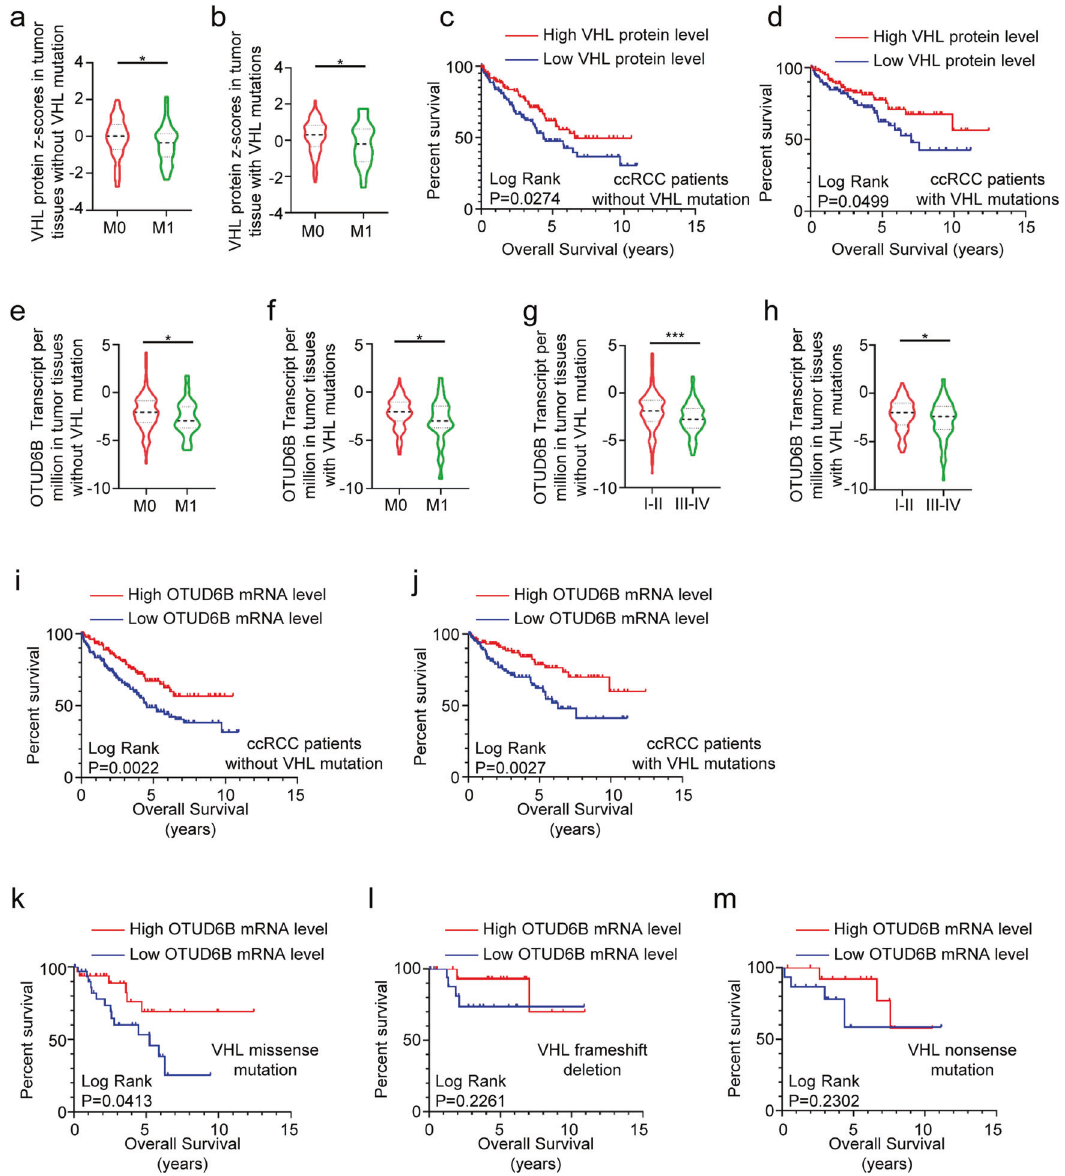
Fig. 1 Low OTUD6B level predicts poor survival in ccRCC. a – j The ccRCC samples were grouped into two cohorts, VHL wild type and VHL mutation. a, b Relative VHL protein level in the tumor tissues of ccRCC patients with stage M0 or M1 were analyzed in the two cohorts respectively. Results are displayed as mean ± s.d. * P < 0.05, Student ’ s t test. c, d The Kaplan – Meier curves of pVHL in ccRCC patients with VHL wild type ( c ) or VHL mutations ( d ) for overall survival (OS). e, f Relative OTUD6B mRNA levels in the tumor tissues of ccRCC patients with stage M0 or M1 were analyzed in the two cohorts respectively. Results are displayed as mean ± s.d. * P < 0.05, Student ’ s t test. g, h Relative OTUD6B mRNA levels in the tumor tissues of ccRCC patients with stage I – II or III – IV were analyzed in the two cohorts respectively. Results are shown as mean ± s.d. * P < 0.05, *** P < 0.001, Student ’ s t test. i, j The Kaplan – Meier curves of OTUD6B in ccRCC patients with VHL wild type ( i ) or VHL mutations ( j ) for OS. k – m The Kaplan – Meier curves of OTUD6B in ccRCC patients with missense mutation ( k ), frameshift deletion ( l ) and nonsense mutation ( m ) for